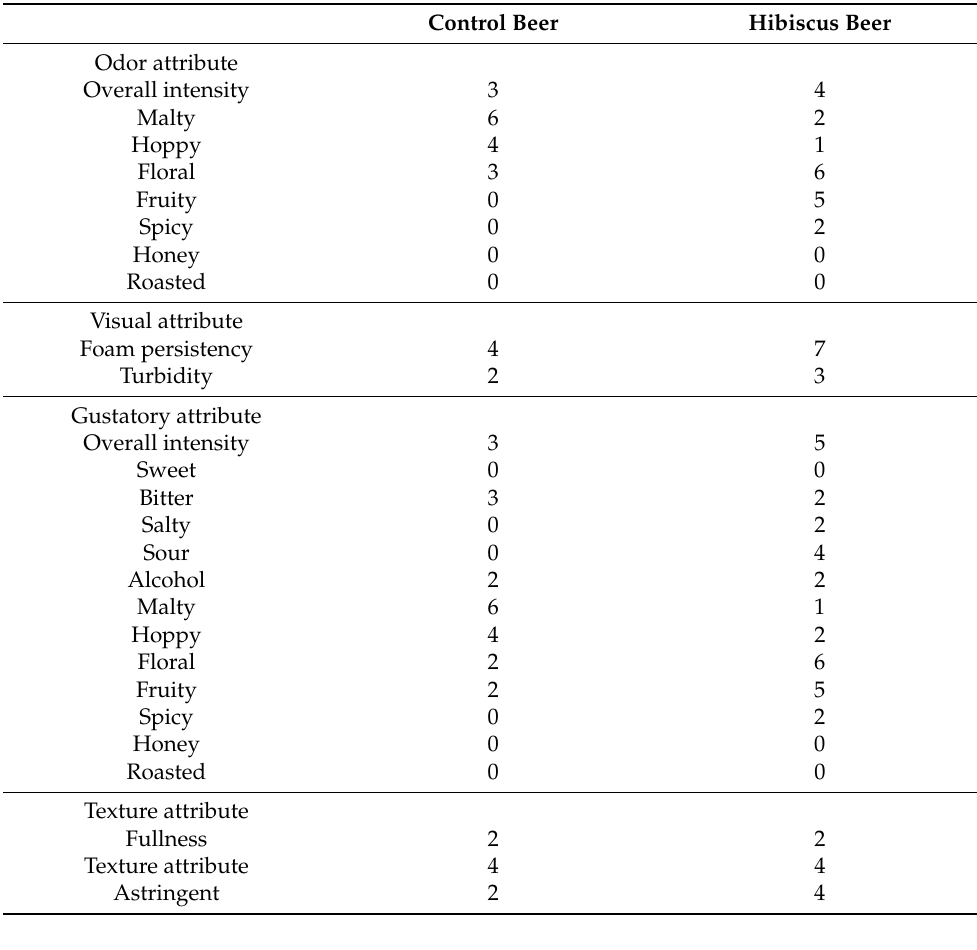
Table 6. Average scores of the QDA analysis attributes for control and hibiscus beers.